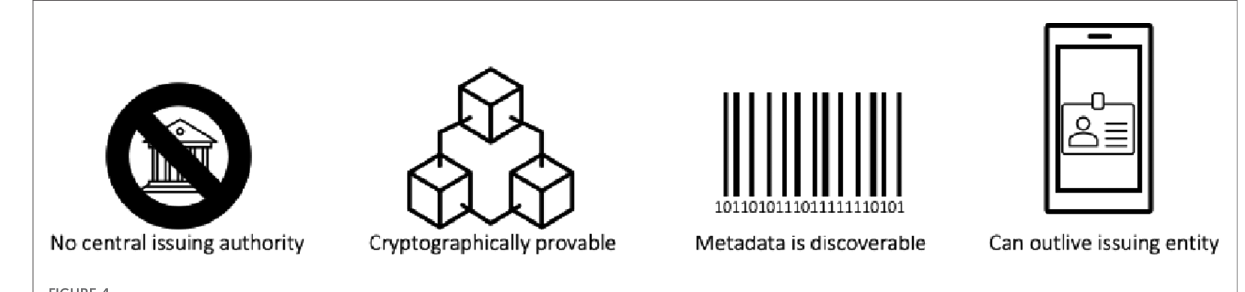
FIGURE 4 Characteristics of a decentralized ID